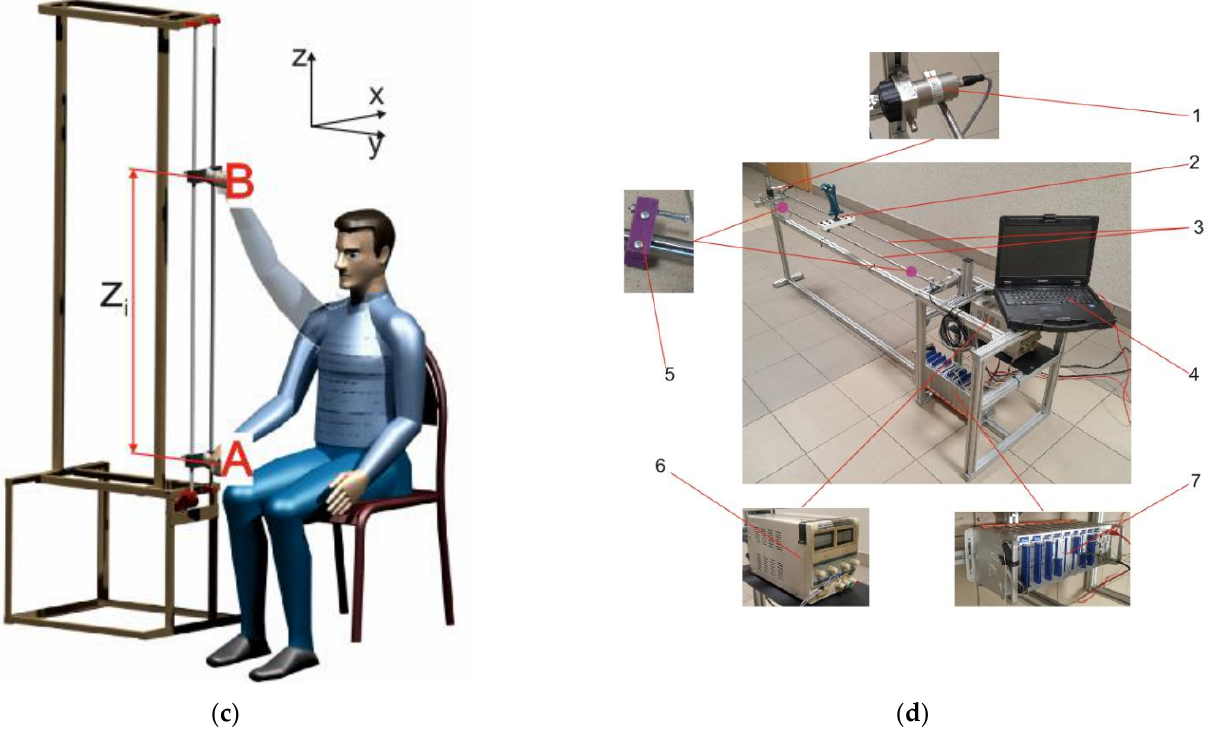
Figure 2. Studies of reaching hand movements: ( a ) longitudinal movement tests; ( b ) lateral movement tests; ( c ) vertical movement tests; ( d ) test stand: 1—linear encoder, 2—moved element (handle grabbed by the operator’s hand), 3—guides, 4—data acquisition device, 5—spring stop, 6—power supply, 7—measurement card, A—starting point, B—point determining the goal of the movement.